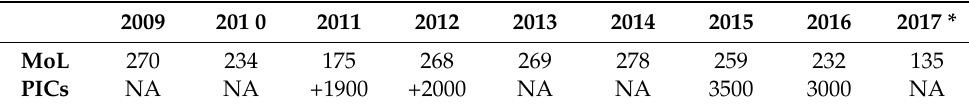
Table 5. Number of injuries by manufacturing industries as reported by the Ministry of Labor (MoL) and the Palestinian insurance companies (PICs) during the target